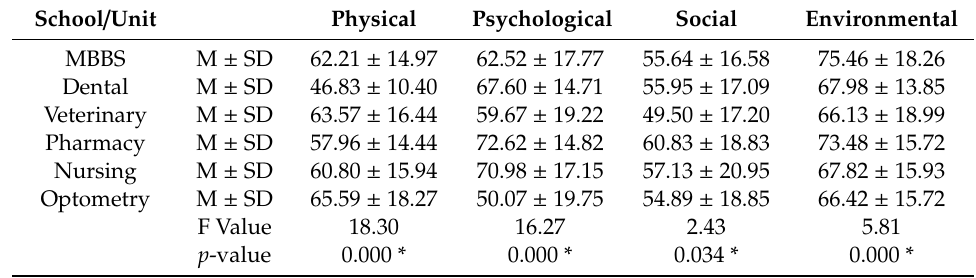
Table 3. Comparative analysis of faculty of medical sciences students in the domains of QOL. School /